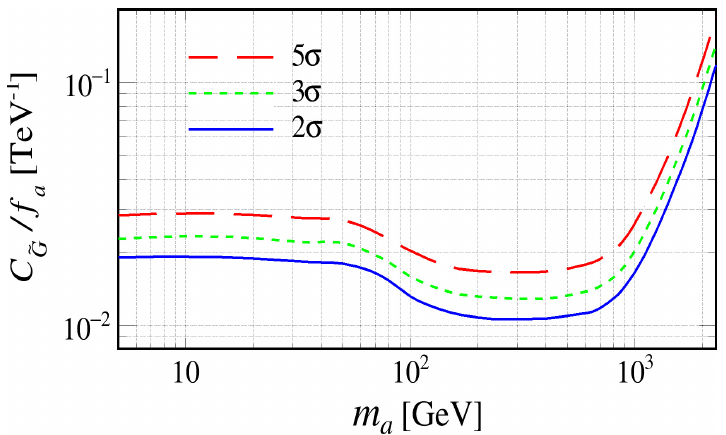
Figure 4 . Upper limits on the model parameter C ˜ /f a for ALP mass m a in range 5–2300 GeV at G 2- σ (solid, blue), 3- σ (short dashed, green) and 5- σ (long dashed, red) significances at the HL-LHC with a center-of-mass energy of 14 TeV and integrated luminosity 3 ab − 1